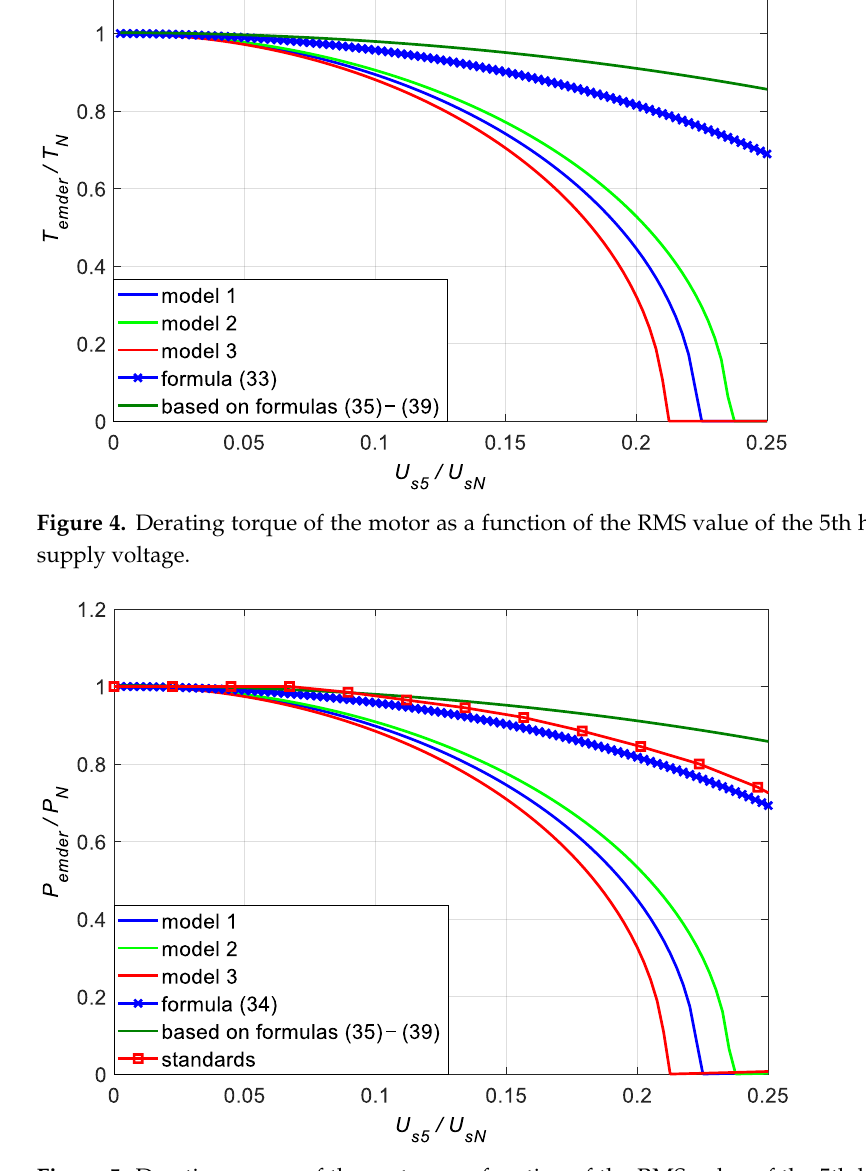
Figure 5. Derating power of the motor as a function of the RMS value of the 5th harmonic of the supply voltage.